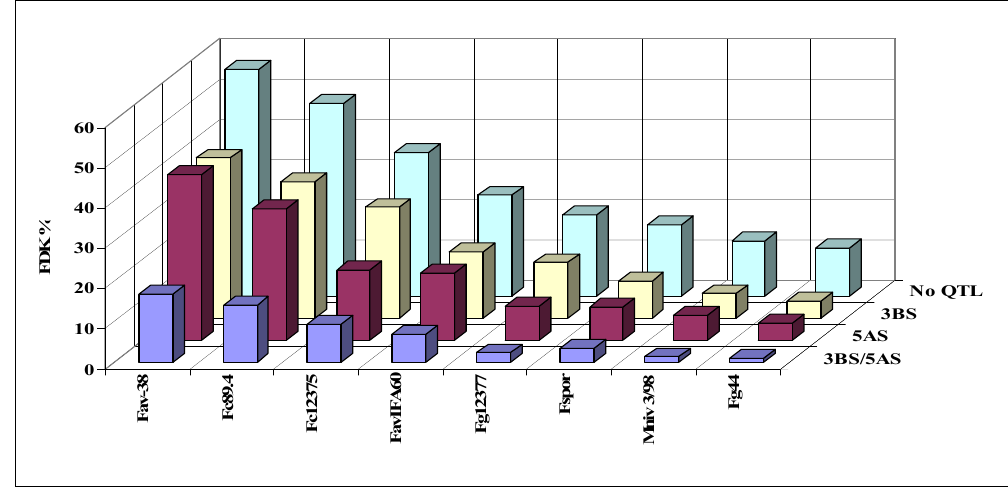
Figure 9. Resistance protection of QTLs 3BS and 5AS against eight isolates of Fusarium on the CM82036/Remus population in wheat, Szeged ‐ Tulln, 2002–2003. Fav: F. avenaceum , Fc: F. culmorum , Fg: F. graminearum , Fspor: F. sporotrichioides and Mniv: Microdochium nivale , F. nivale , Gerlachia nivalis [48].